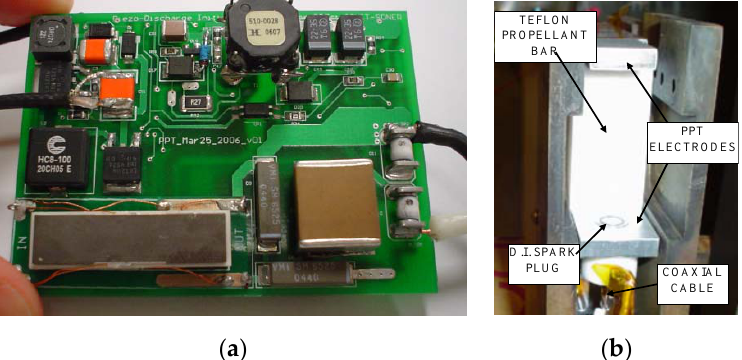
Figure 21. 15 kV initiation spark generated with the IGNIT-SONER prototype system under 1.10 − 3 torr vacuum conditions. ( a ) Prototype of the IGNIT-SONER, ( b ) Vacuum chamber with a Pulsed Plasma